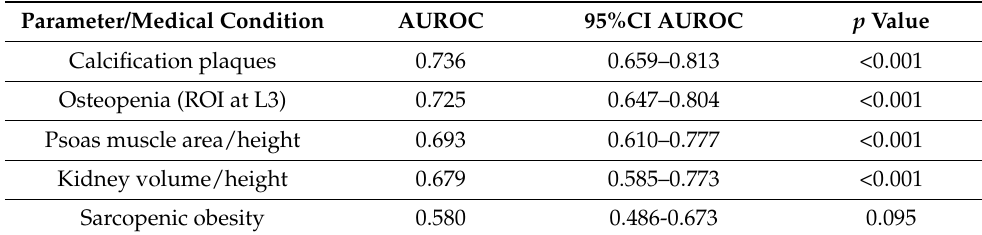
Table 3. ROC curves for 30-day mortality.